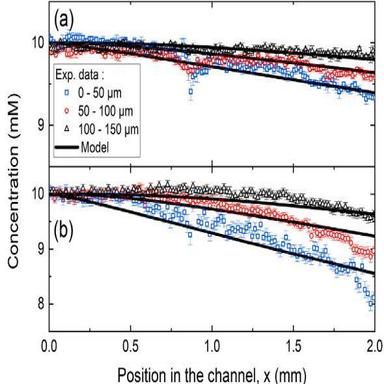
Comparison of the concentration distributions in the depletion zone for 3 ypositions to the analytical model once and 0 were estimated. Results obtained at (a) 20 μA and (b) 40 μA. The error bars were computed from the standard deviation of the measurements over 50 images.